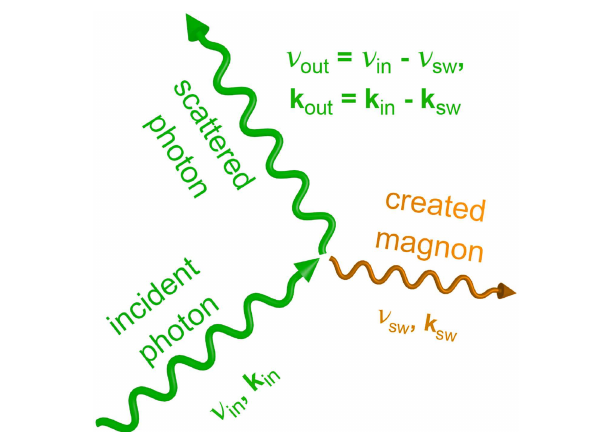
FIGURE 2 | Sketch of the BLS process. The incident light with wave vector k in and frequency ν in generates a spin wave ( k sw , ν sw ) in the Stokes process. Energy and momentum conservation lead to a reduced wave vector k out and a smaller frequency ν out of the scattered